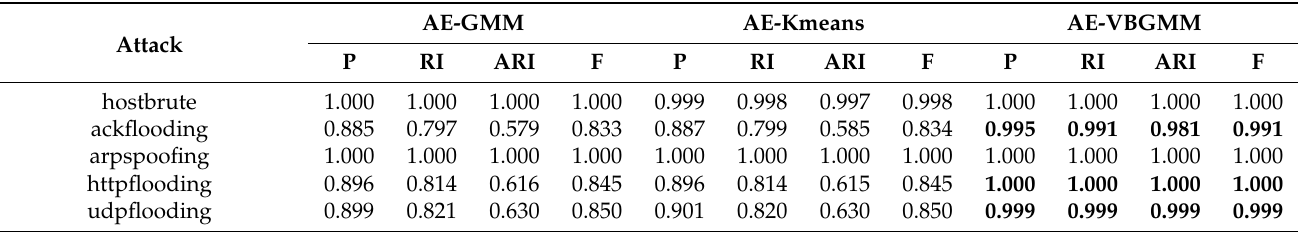
Table 4. P, RI, ARI, and F-score of AE-GMM with AE-VBGMM and AE-Kmeans with AE-VBGMM for anomaly detection. The best value of each evaluation criterion is marked in bold.